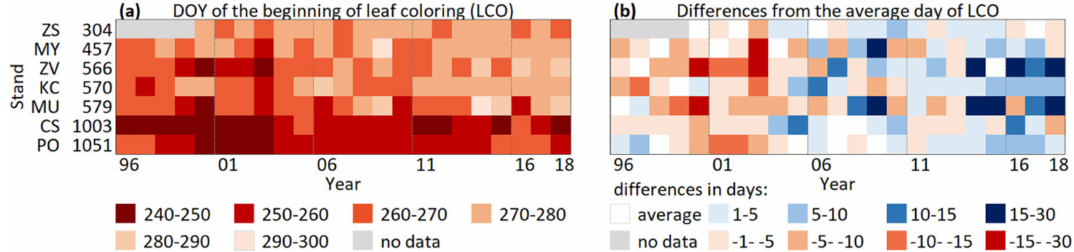
Figure 6. The onset of leaf colouring (LCO) at beech stands during the period 1996–2018 ( a ) and the di ff erences from the average DOY (Day of Year) of LCO ( b ): the prevailing blue colour after 2006 in ( b ) highlights later LCO at beech stands, especially at middle